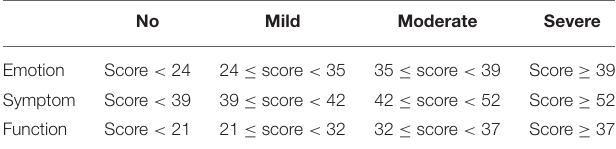
TABLE 1 | Cut-off score for each domain of the